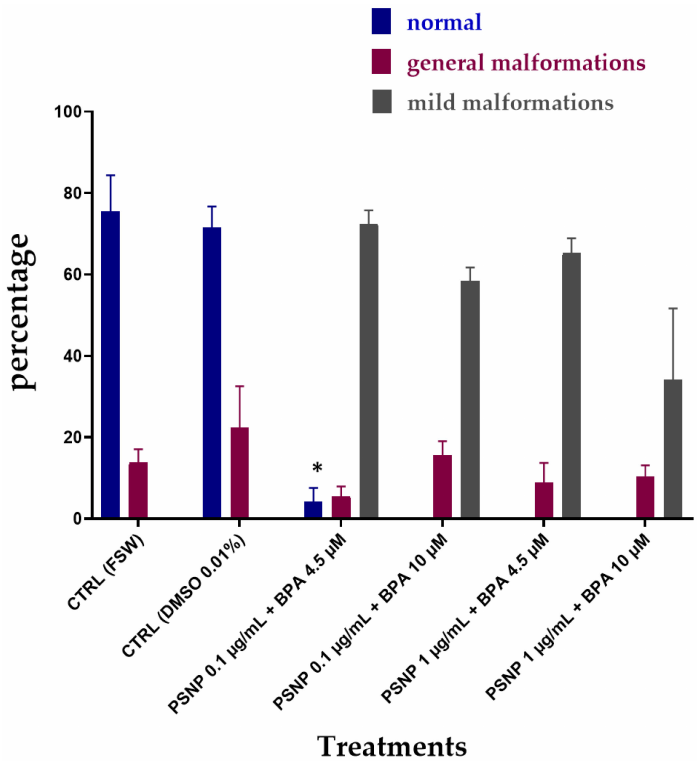
Figure 3. The percentage (%) of C. robusta larvae normally hatched with general malformations (red) and with mild malformations (grey) upon combined exposure without pre-incubation (T0) to PS NPs and BPA in FSW. Bars show mean ± Standard Deviation. * indicates values that are significantly different compared to the controls (2-way ANOVA, p < 0.05). Table 3. The percentage (%) of normal hatched larva and undeveloped embryos of C. robusta upon combined exposure without pre-incubation (T0) to non-functionalized PS NPs and BPA in